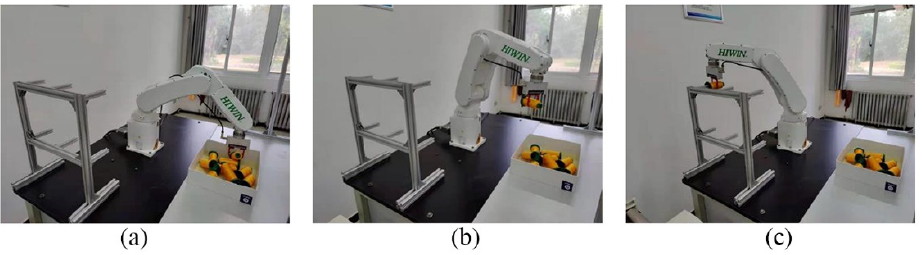
Figure 10. Diagram of the gripping process of part of the yarn bobbin. ( a ) grasping operation, ( b ) transmissing operation, and ( c ) loading operation.